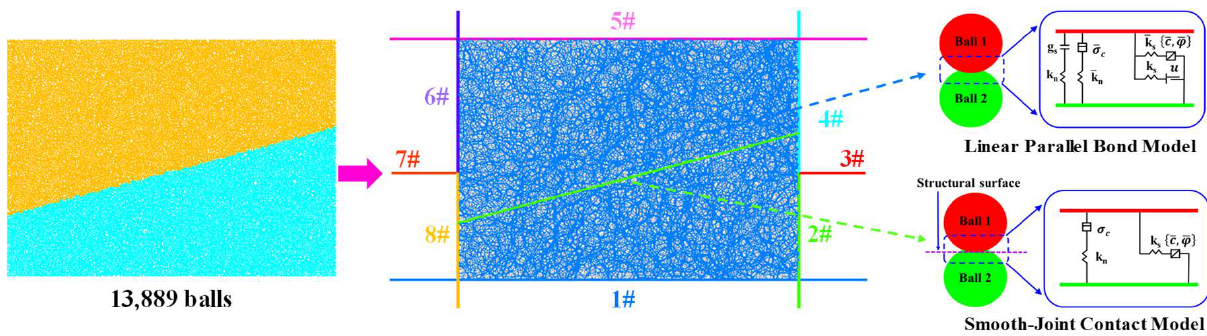
Figure 5. Numerical model of 2-L-15.